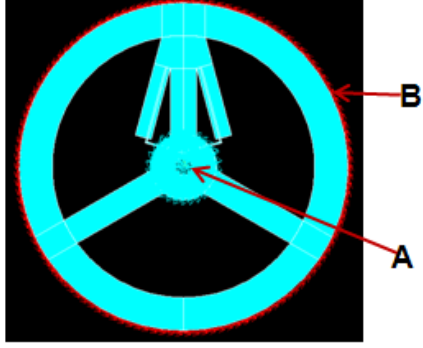
Figure 6. Boundary condition of the TSHS.